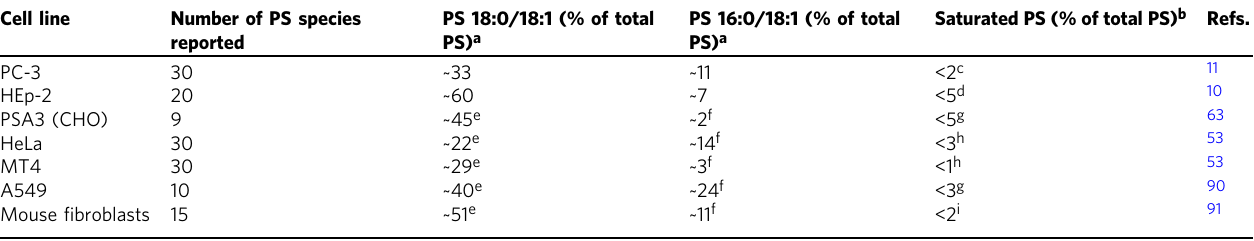
Table 2 Percent of PS 18:0/18:1, PS 16:0/18:1 and PS species with two saturated FAs Cell